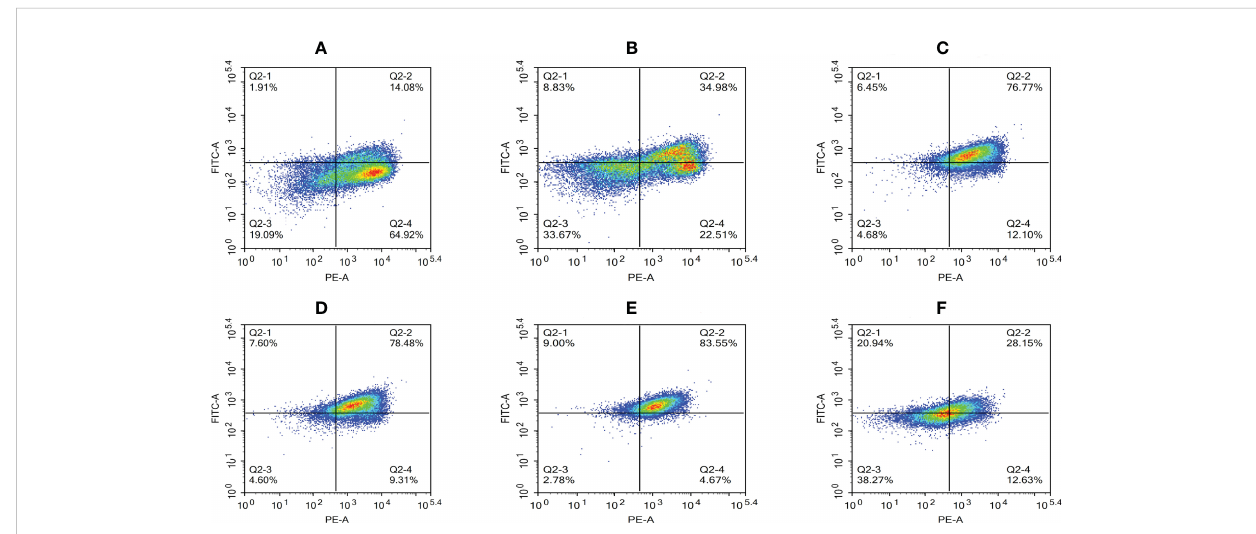
FIGURE 10 Proportion of cells with decreased mitochondrial membrane potential at different time periods. (A) Uninfected cells, (B) 2 hpi, (C) 4 hpi, (D) 6 hpi, (E) 8 hpi, and (F) 12 hpi.